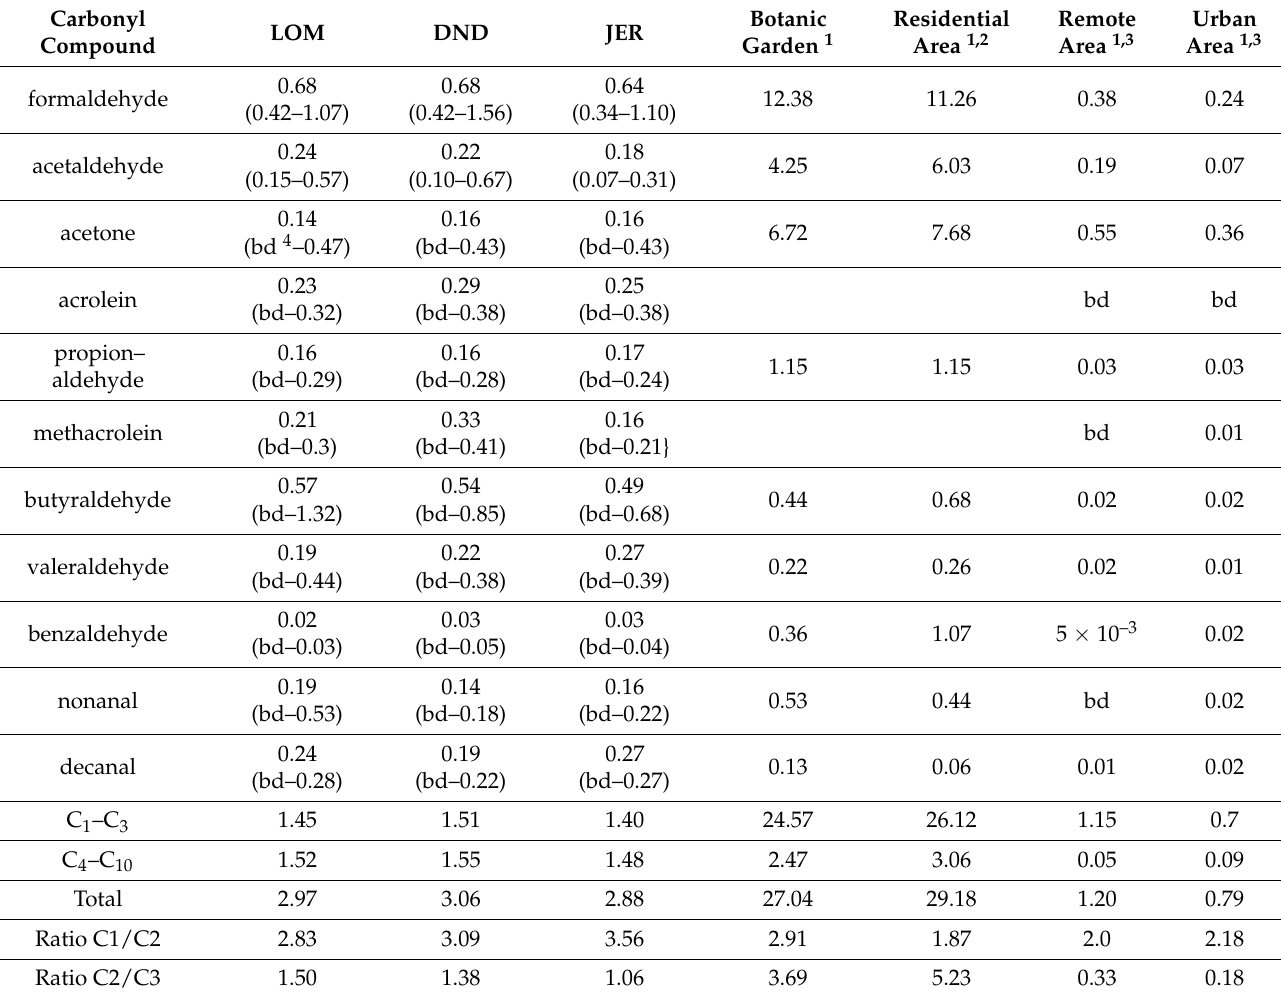
Table 5. Arithmetic means and range of carbonyl concentrations (ppb) at three diverse sites based on passive sampling, the Botanic Garden, and a residential area in Guangzhou, China [58], and a remote forested area in Finland [55] and an urban area in Finland, Helsinki